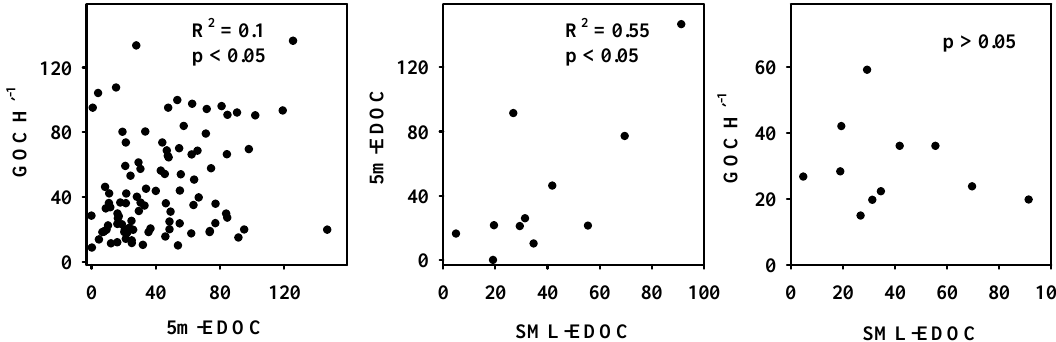
Figure 8. Relationship between GOC H 0− 1 and EDOC at 5m depth (left panel), relationship between EDOC at 5m depth and EDOC in the surface microlayer (SML-EDOC) (middle panel) and the relationship between GOC H 0− 1 and SML-EDOC (right panel).